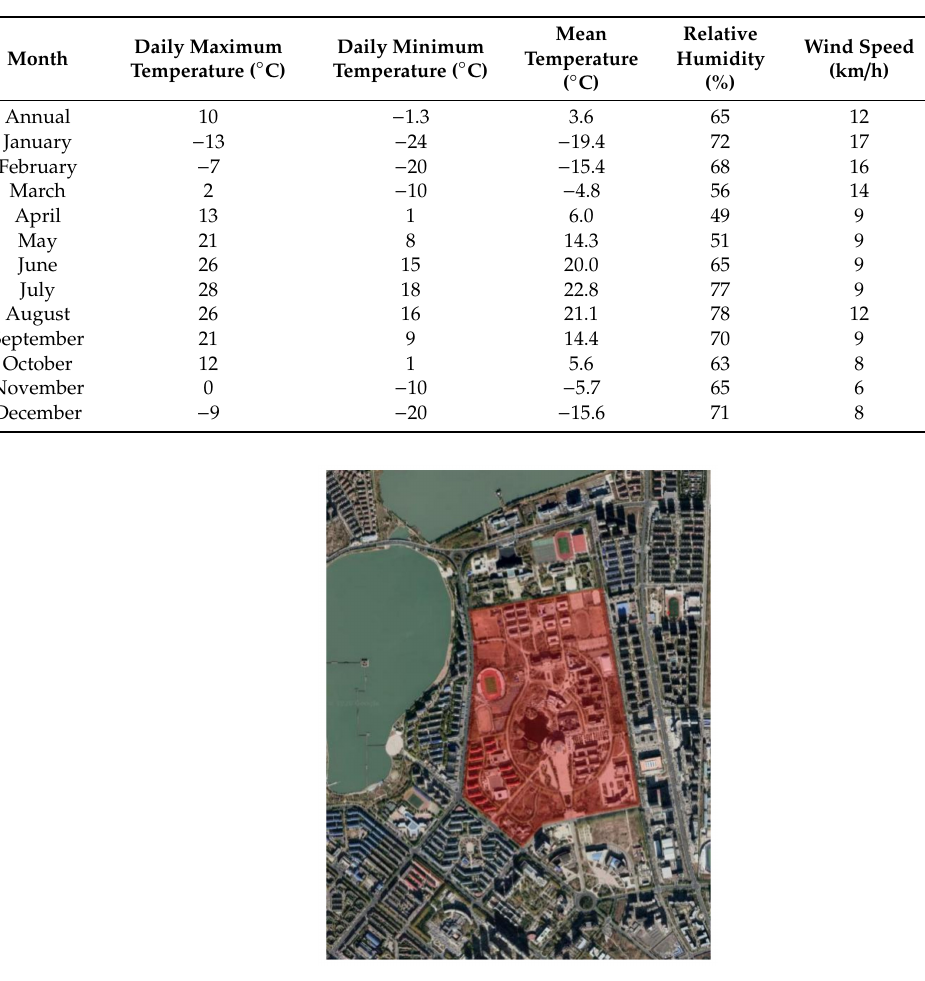
Table 1. Basic meteorological information of Daqing (2007–2017).